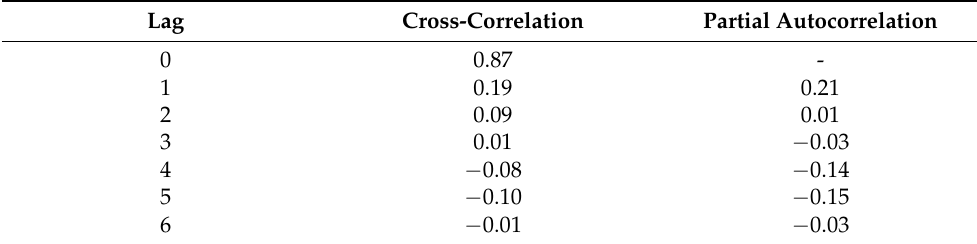
Table 3. Cross-correlation between monthly SSC and discharge data with 5% significance limits and partial autocorrelation for monthly SSC data with 5% significance limits for Boostan Dam Watershed.